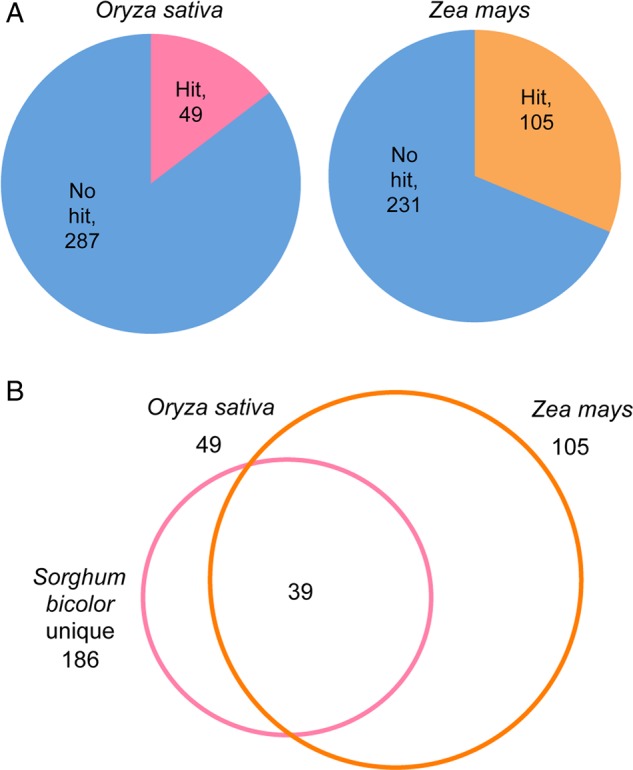
Comparative analyses of newly identified genes in O. sativa and Z. mays genomes. The newly identified genes were searched against annotated genes of each species. (A) Pie chart shows the number of genes that were hit or were not hit in each species. (B) The overlapping matches between species are displayed in the Venn diagram. Sorghum unique shows non-homologous gene in an analysis using blastp with an e-value ≤0.001 against NCBInr.